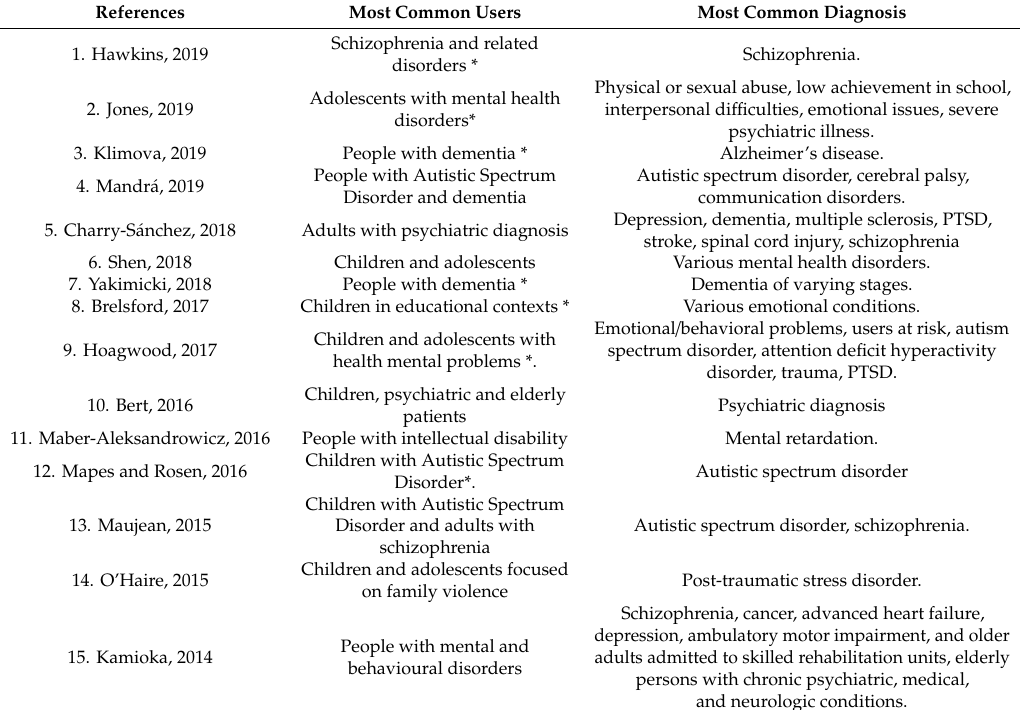
Table 2. Involved patients or users in animal-assisted interventions (AAIs), according to each